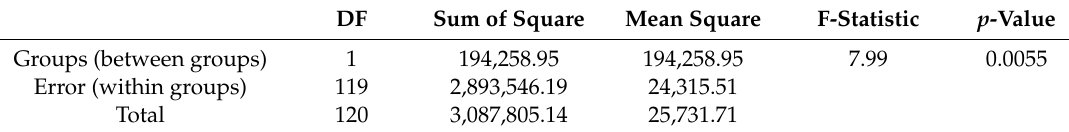
Table 6. Assumptions of normal distribution and homogeneity of variances.